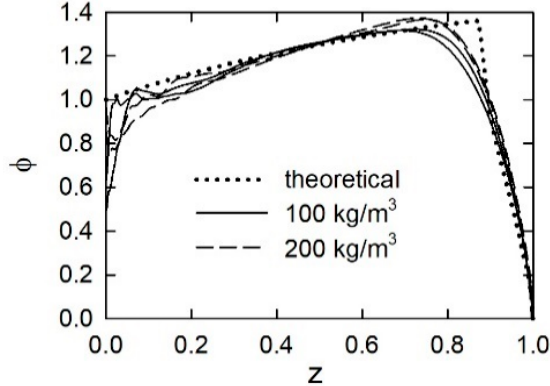
Figure 12. Experimental and theoretical form–function plots for LO5460 (JA-2) propellant.